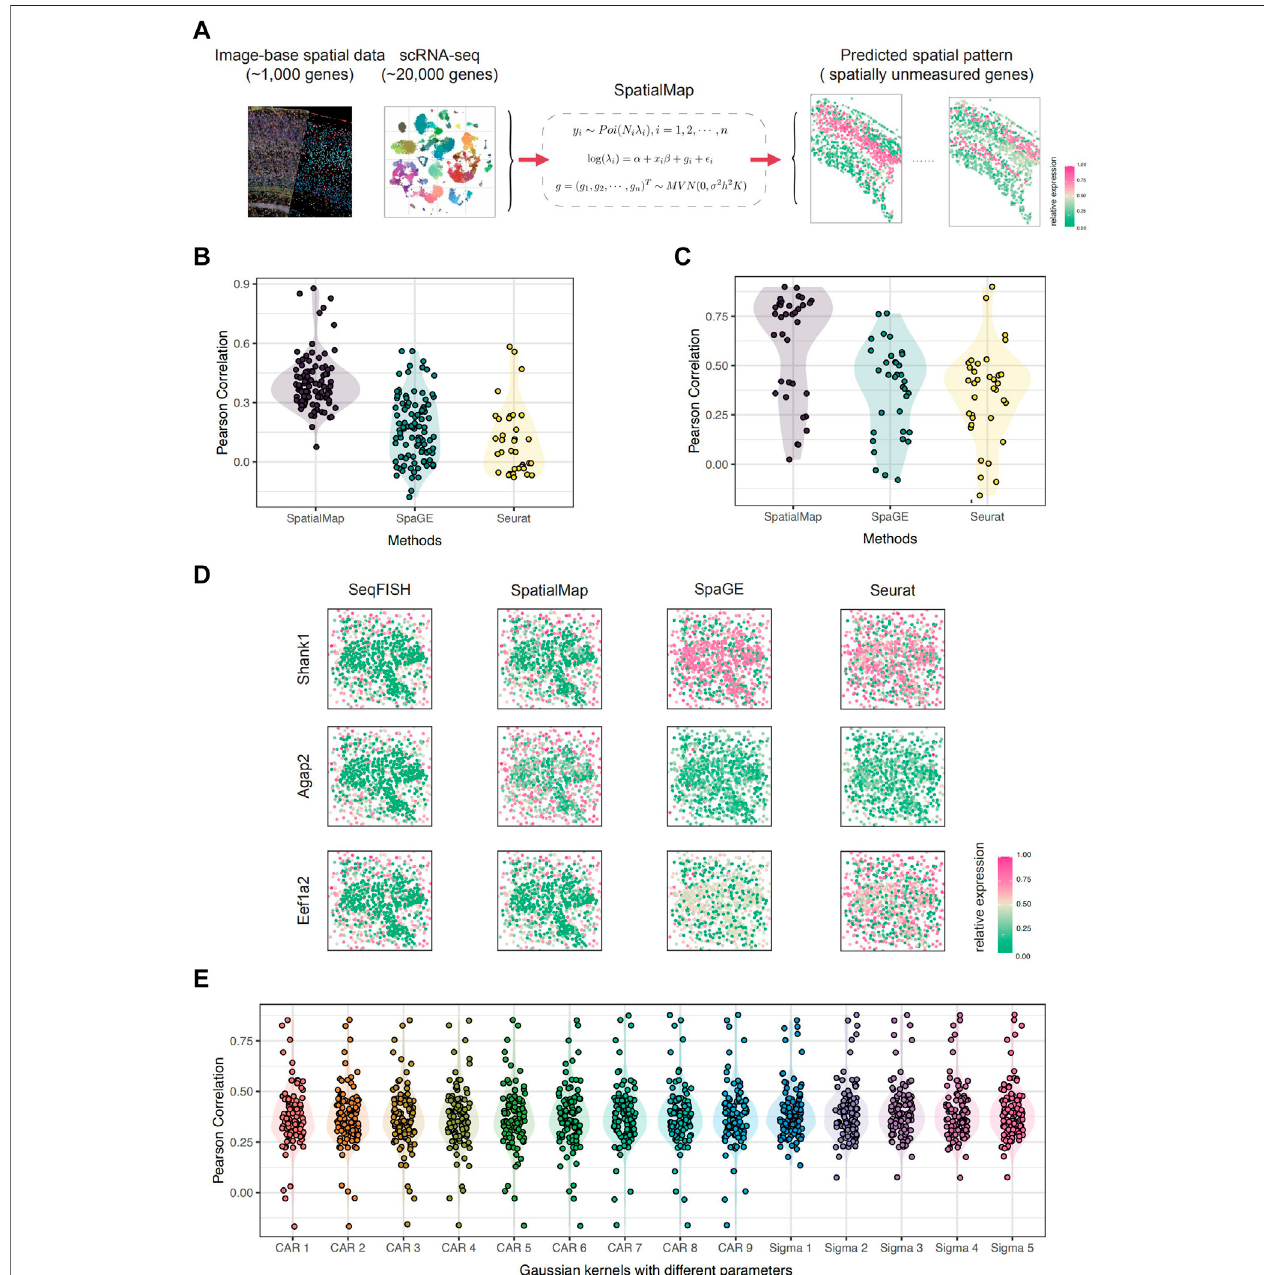
FIGURE1| OverviewofSpatialMap. (A) PipelineofSpatialMap.SpatialMaptakestissue-pairedimage-basedspatialdata(containabout1,000genes)andscRNA- seq data (contain about 20,000 genes) as inputs, aiming to predict expression patterns for spatially unmeasured genes using a generalized linear spatial model. (B) Pearson correlations between predictions and original values of randomly selected 100 genes from experiments on the SeqFISH dataset. The mean values are 0.402, 0.168, and 0.108; minimum values are 0.074, − 0.178, and − 0.078; and maximum values are 0.878, 0.560, and 0.583 for SpatialMap, SpaGE, and Seurat, respectively.Eachdotrepresentsanindividualgene. (C) PearsoncorrelationsbetweenpredictionsandoriginalvaluesofSPARK-selected35genesfromexperimentson theSeqFISHdataset.Themeanvaluesare0.607,0.377,and0.355;minimumvaluesare0.024, − 0.079,and − 0.158;andmaximumvaluesare0.899,0.764,and0.899 for SpatialMap, SpaGE, and Seurat, respectively. (D) Visualization of predicted spatial expressions. Pearson correlations are 0.825, 0.814, and 0.894 for SpatialMap- performed genes Shank1 , Agap2 , and Eef1a2 , respectively. Color represents the relative gene-expression level (purple, high; green, low) (E) Pearson correlations between predictions and original values using different kernel functions in SpatialMap. “ CAR 1 ” to “ CAR 9 ” indicates CAR prior concerning spatial parameters being 0.1 to 0.9, and “ Sigma 1 ” to “ Sigma 5 ” indicates the Gaussian kernel with fi ve chosen various scaling parameters. Color represents different kernels used in SpatialMap.